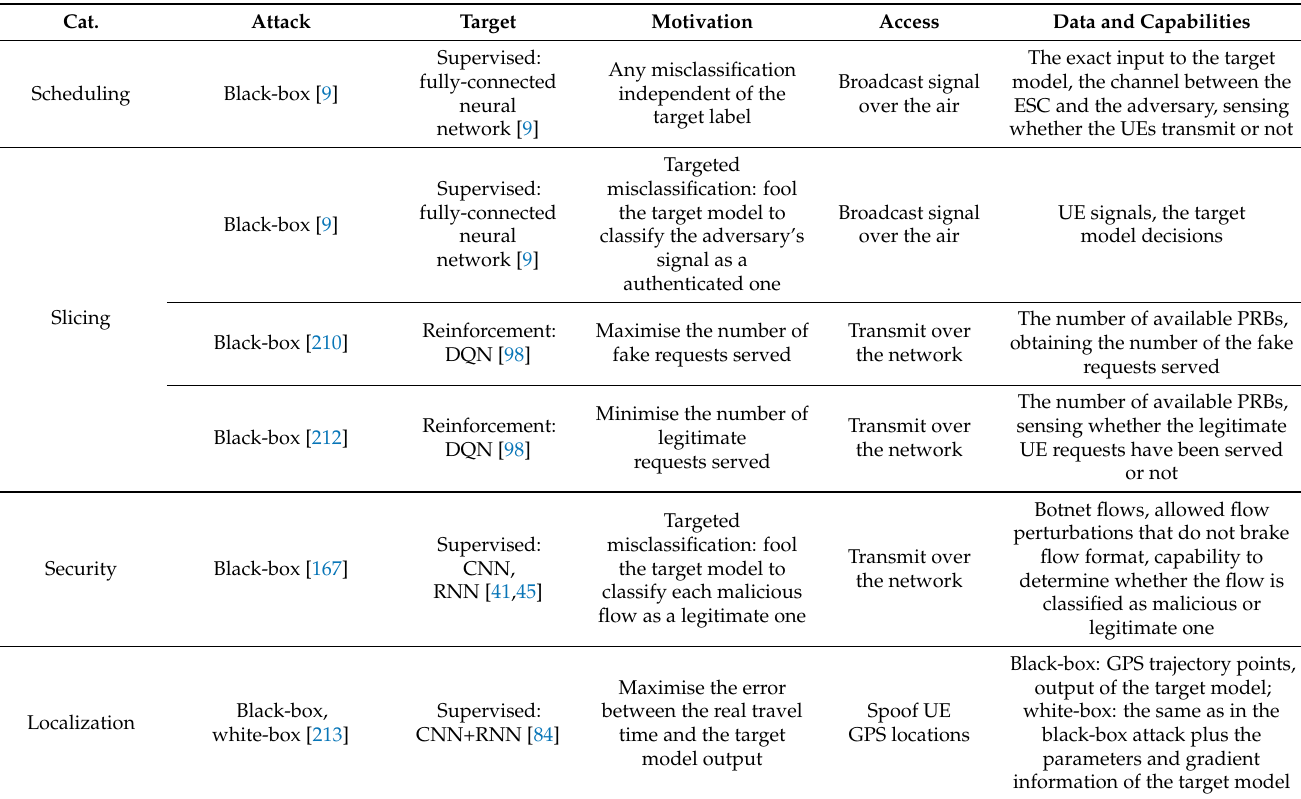
white-box: the same as in the black-box attack plus the parameters and gradient information of the target